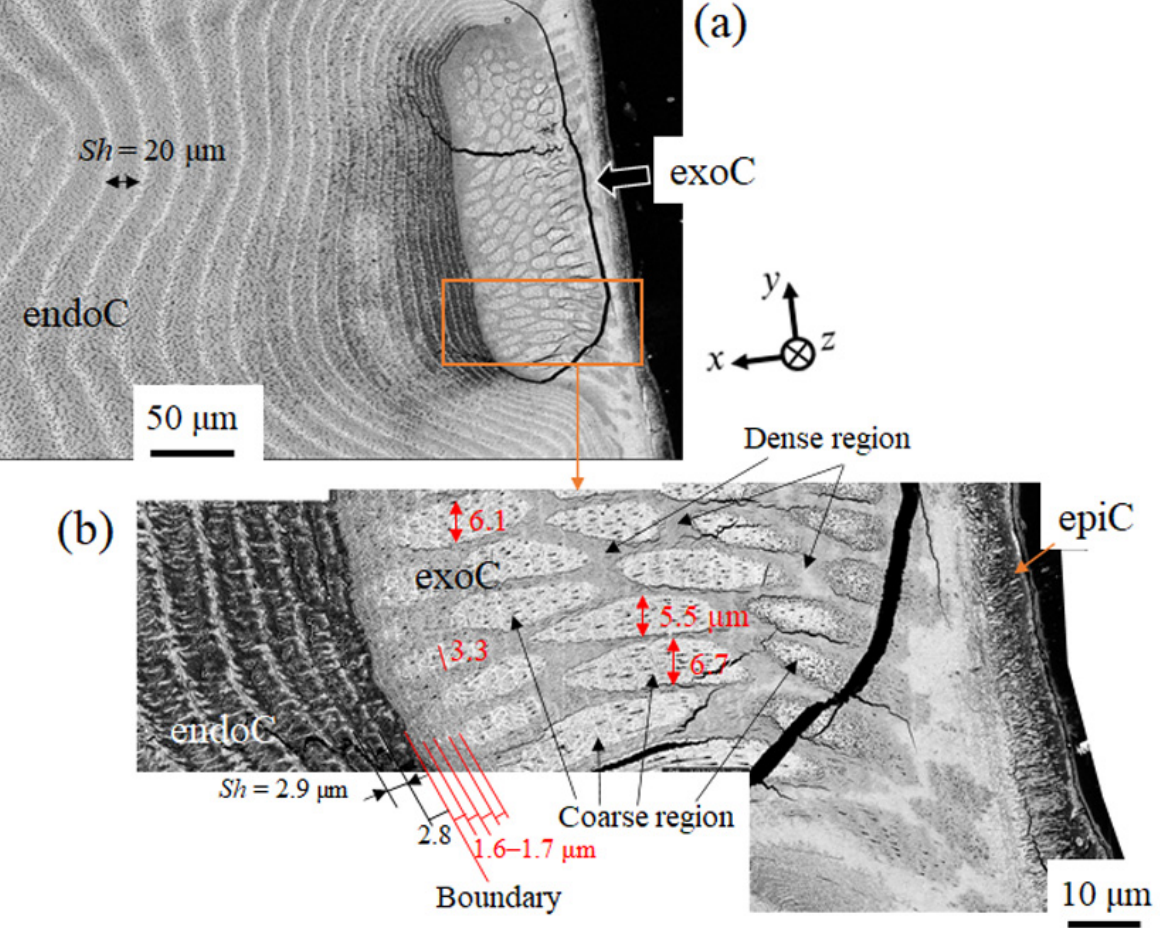
Figure 9. ( a ) SEM image of a cross section of the mottled, deep-blue surface and ( b ) enlarged view of the exocuticle surrounded by a rectangle in ( a ).